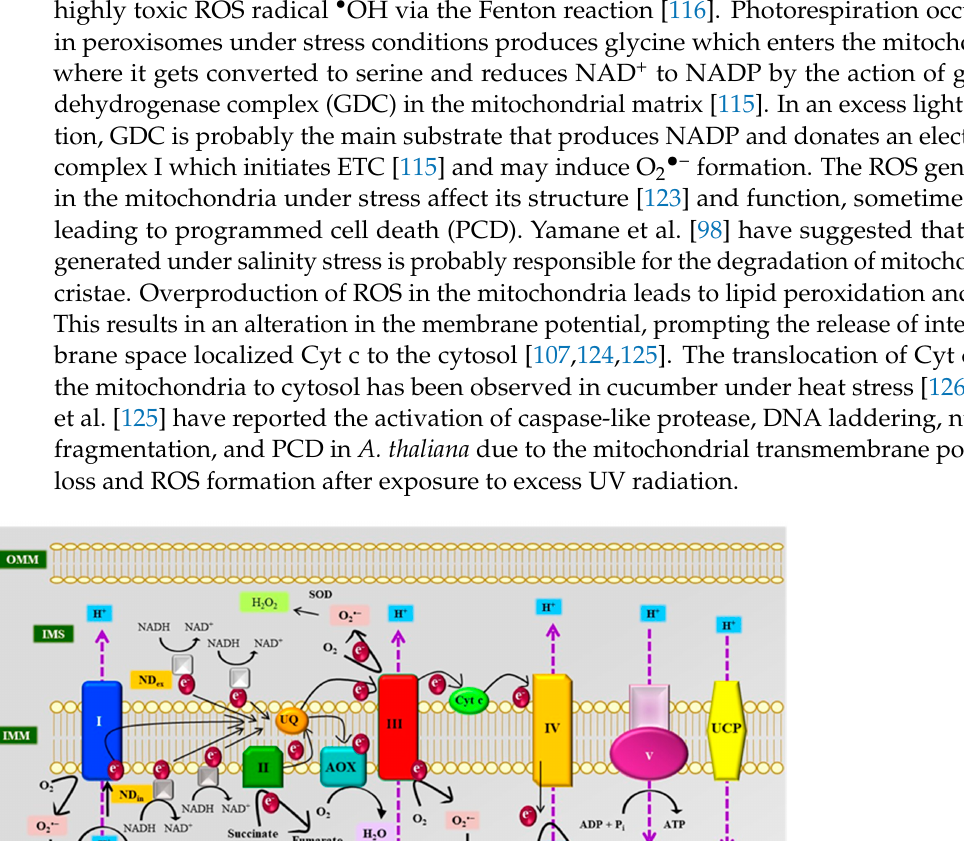
an alternative pathway consisting of two each NDex and NDin with AOX and UCP which limit ROS generation. NDex and NDin function in stress conditions and transfer electrons to UQ. The AOX present between UQ and complex III accepts an electron from UQ and reduces O 2 to H 2 O, thus terminating the electron transport to complex III. OMM: Outer